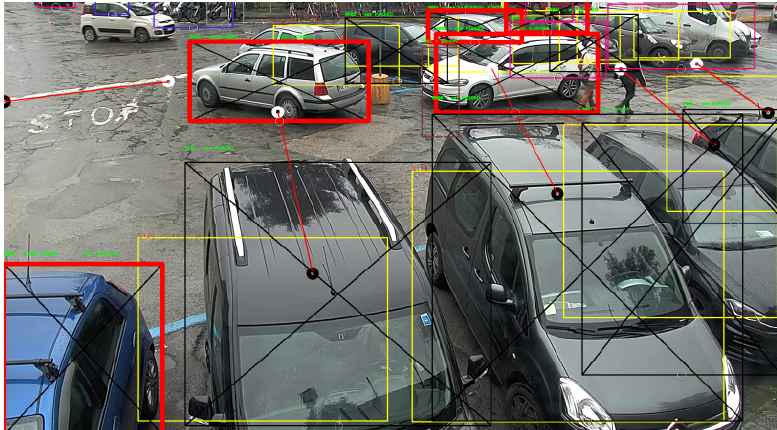
Figure 1. Examples of detections in the parking lot of Piazza Tasso. The yellow boxes denote annotated parking spots. The black crossed vehicles are in the parked state. The red boxes denote